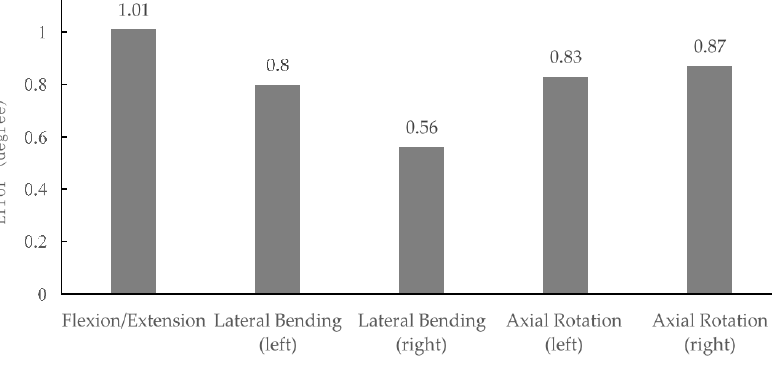
Figure 11. The accuracy of the system for planar movements for all participants.